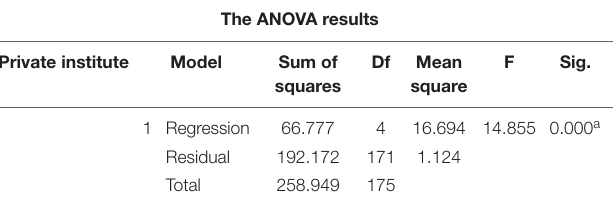
TABLE 10 | The ANOVA results for private institute learners.